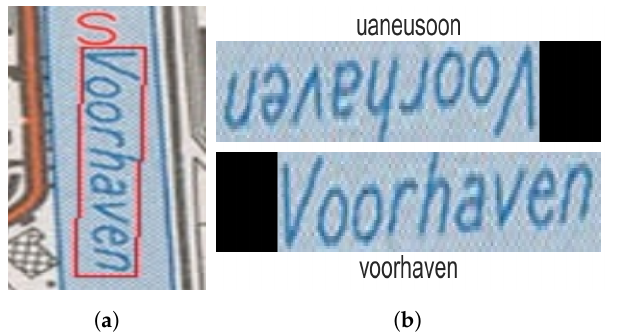
Figure 4. An example of the proposed solution for vertically oriented text. ( a ) The text was incorrectly recognized as the character “s”. ( b ) Text recognition result after warping the text in both